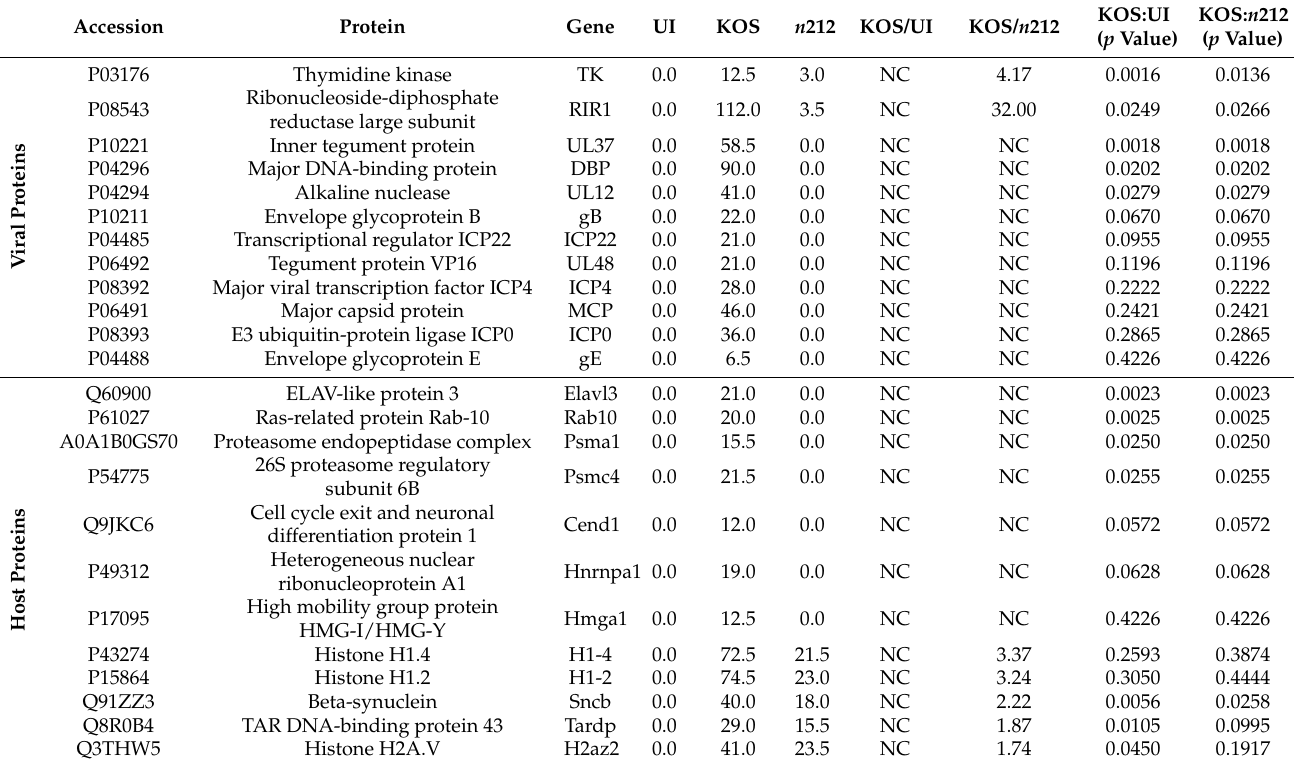
Table 1. Virus and host proteins identified by LC-MS/MS as